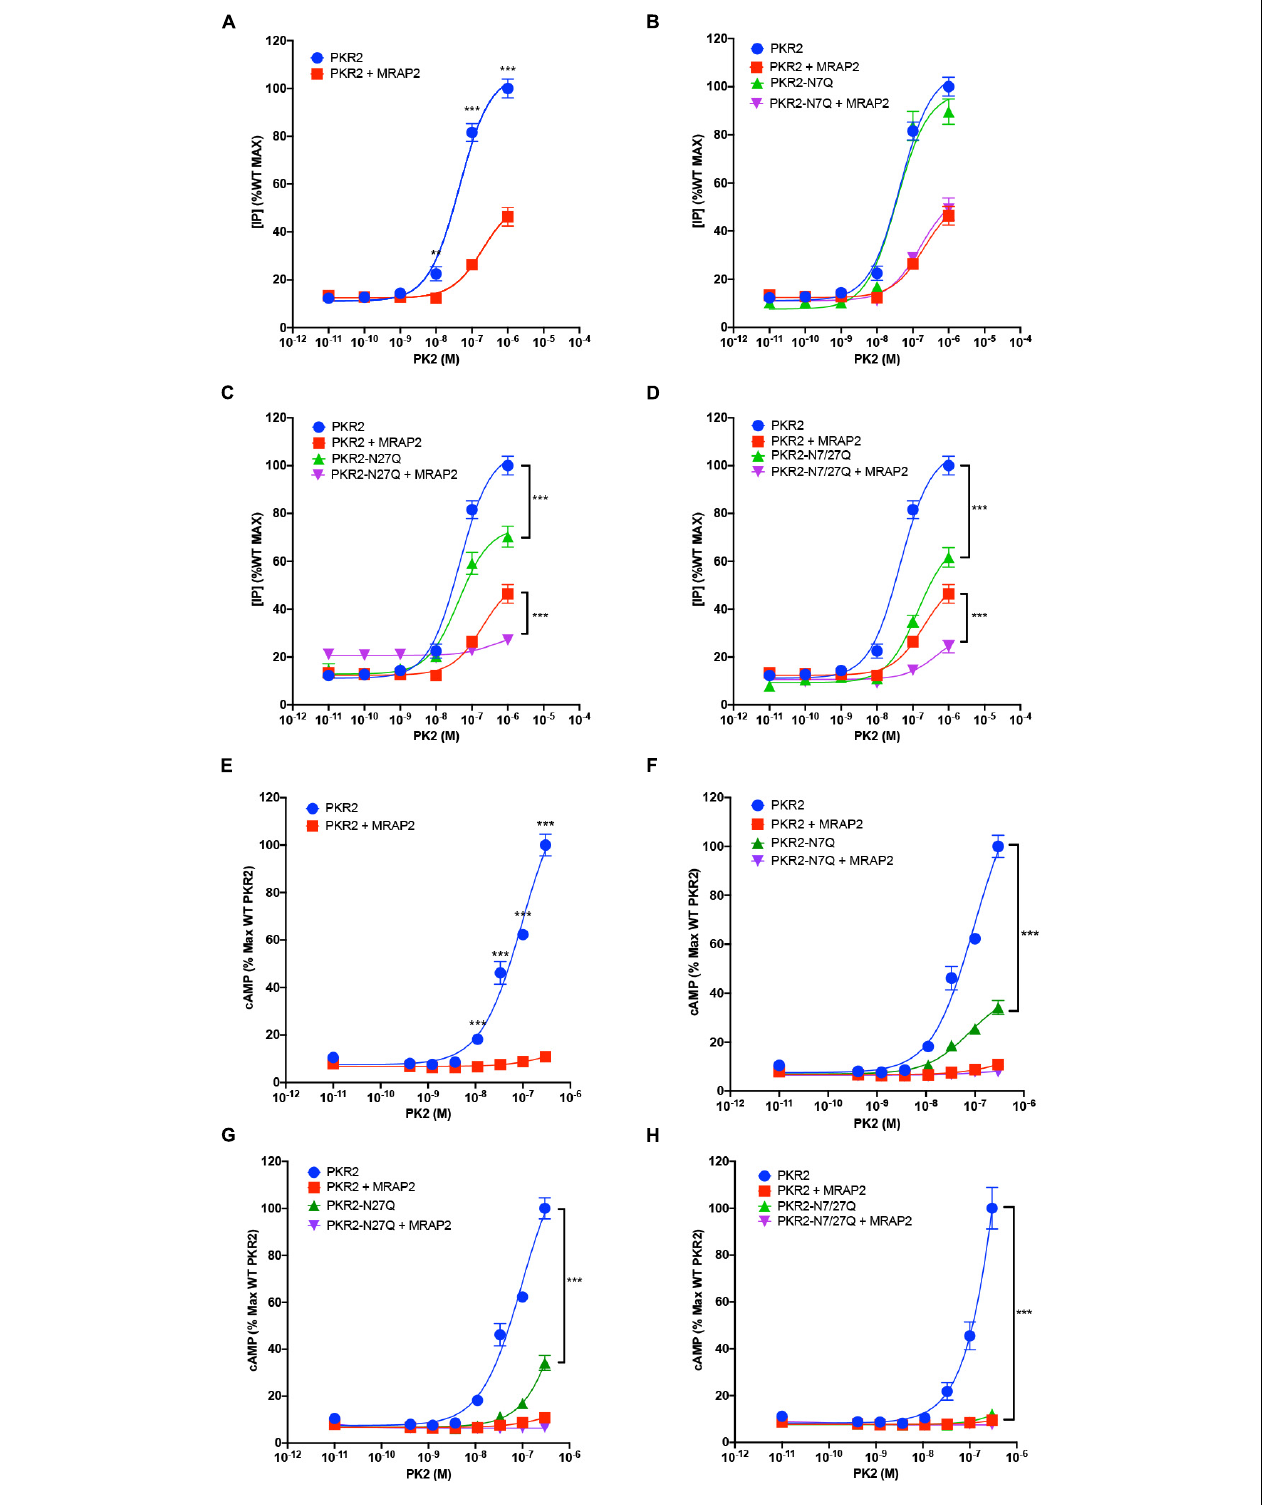
FIGURE 4 | Role of N-glycosylation in PKR2 signaling. (A–D) Inositol phosphate detection in cells expressing PKR2 (A) , PKR2-N7Q (B) , PKR2-N27Q (C) , or PKR2-N7/27Q (D) with or without MRAP2 and stimulated with the indicated concentration of PK2. (E–H) cAMP measurement in cells expressing PKR2 (E) , PKR2-N7Q (F) , PKR2-N27Q (G) , or PKR2-N7/27Q (H) with or without MRAP2 and stimulated with the indicated concentration of PK2. Errors are mean ± SEM. ** p < 0.01, *** p < 0.001.